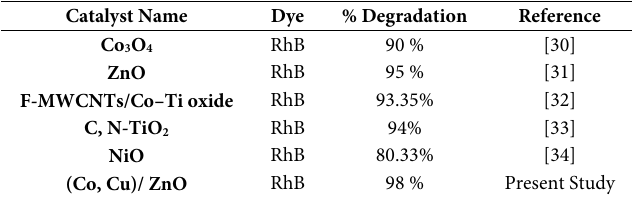
Table. 2. Comparison of the degradation efficiency with other catalysts for